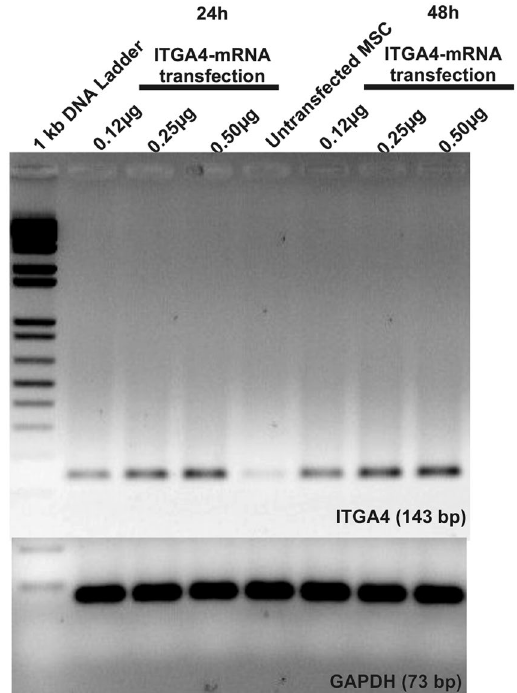
Figure 4. Exogenous ITGA4-mRNA delivery to MSCs. RT-PCR of MSC lysates after ITGA4-mRNA transfection: The higher band refers to ITGA4-mRNA (143 bp) and lower band to housekeeping gene: GAPDH (73 bp).